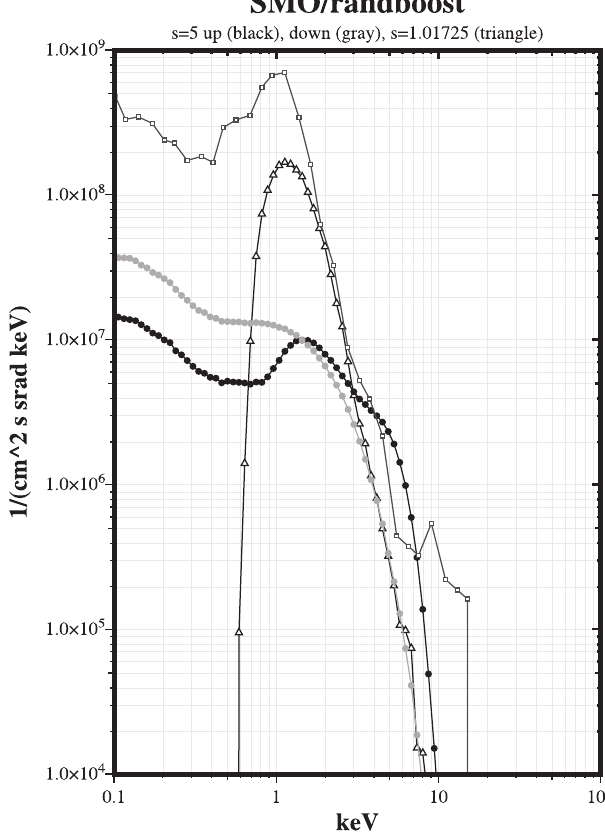
Fig. 11. SMO/randboost: same as model SMO/real (Fig. 10) but with random boosts included. The agreement is approximately as good as in SMU/randboost above